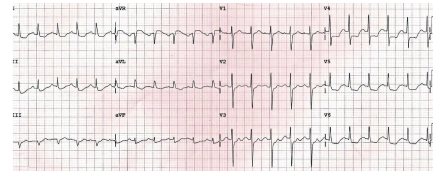
Figure 1: Admission ECG.